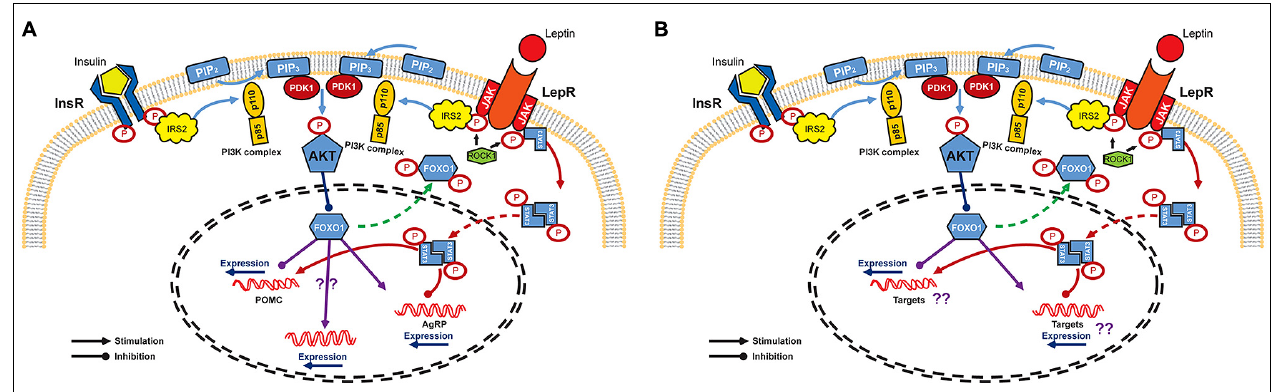
dimeric form of STAT3 translocates to the nucleus where it inhibits AgRP and activates POMC expression. (B) Schematic diagram of insulin and leptin signaling in DA neurons. InR, insulin receptor; LepR, leptin receptor; IRS, insulin receptor substrate; PIP2, phosphatidylinositol-4,5-biphosphate; ROCK1, Rho-kinase 1; PIP3, phosphatidylinositol-3,4,5-triphosphate; PI3K, phosphatidylinositol 3-OH kinase; PDK1, phosphoinositide-dependent kinase-1; Akt, protein kinase B; FoxO1, forkhead transcription factor O1; JAK, Janus kinase; STAT3, signal transducer and activator of transcription 3; POMC, proopiomelanocortin; AgRP, agouti-related